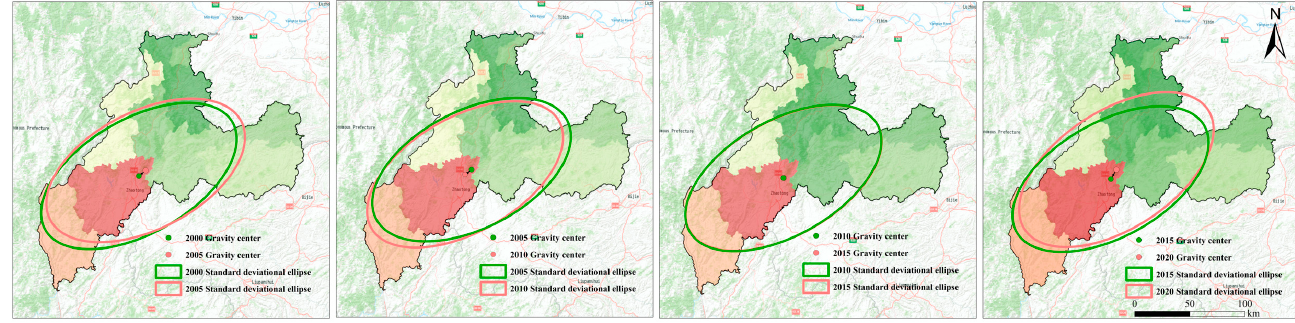
Figure 7. Change direction in Zhaotong from 2000 to 2020.